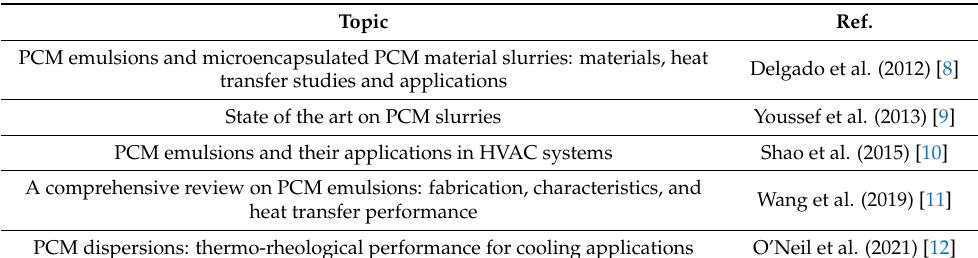
Table 1. List of review articles on PCM emulsions in the last 10 years. Topic